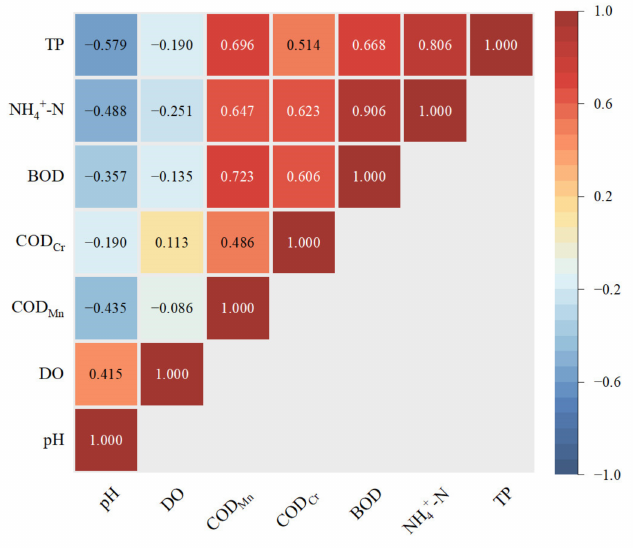
Figure 3. Correlation coefficients of annual water quality